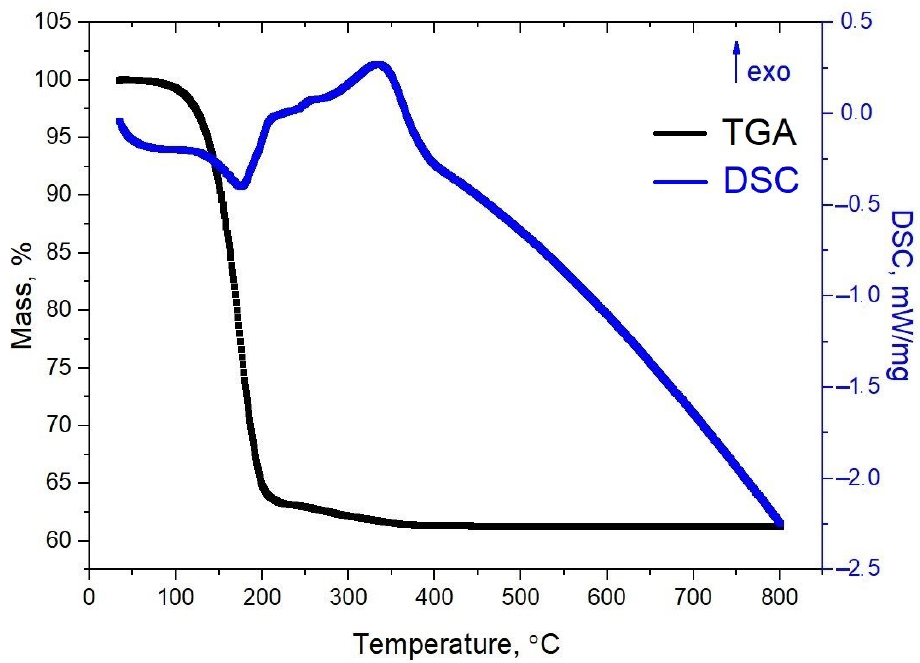
Figure 7. DTA heating curves for NiO/YSZ composite paste obtained in an Ar/O 2 (0.8/0.2) atmosphere.